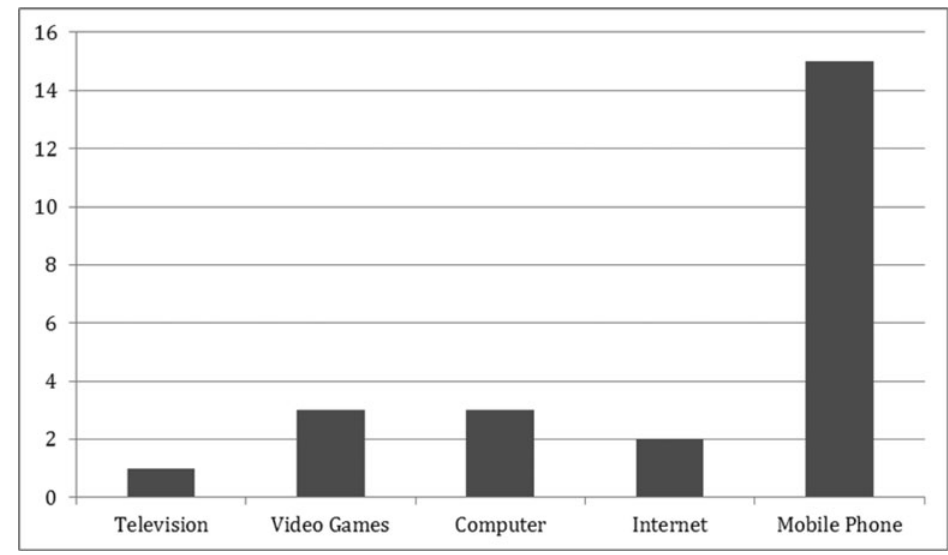
Number of Indigenous adolescents indicating most preferred small screen